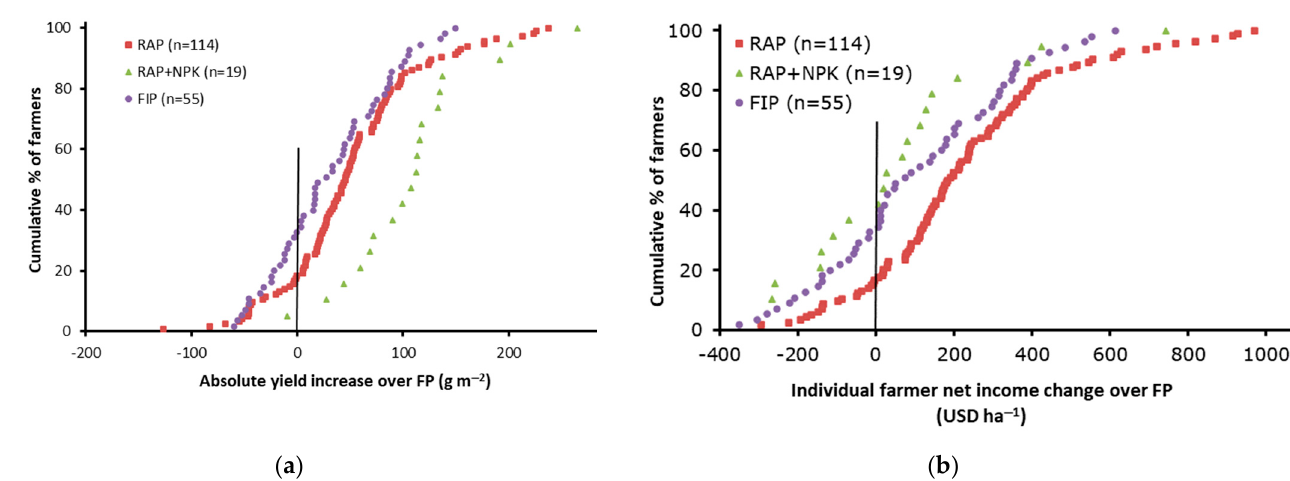
Figure 4. Cumulative frequency for absolute yield increment ( a ) and net income ( b ) over farmers’ practice due to the improved management packages tested: recommended agronomic practices without fertilization (RAP), recommended agronomic practices combined with NPK application (RAP+NPK) and farmers’ intensification practice (FIP) plotted as percentage of farmer population. Under FIP, the different intensification options which farmers considered feasible and, thus, evaluated included line transplanting, timely weeding, fertilizer use, as single options and in all possible combinations. Pair-wise comparison of yield for individual farmers under their current practice and any tested intensification practice, showed that timely weeding alone or in combination with other improved management practices, significantly ( p ≤ 0.01) increased grain yield in the fields of those farmers who evaluated these practices as their intensification options (Figure 5). Timely weeding as a single intensification option, and combined with line transplanting and fertilization, resulted in the highest yield gains of 80 and 73 g m − 2 , respectively, compared with yield under current practice for farmers who implemented these management practices as their intensification options. At an individual farmer’s field, for farmers who tested the different intensification practices, yield increment from different choices in the intensification (FIP) packages in- dicated that farmers who did late weeding under their current practice (FP) but timely weeded as an intensification step (FIP) had the highest yield increment, averaging 75 g m − 2 and ranging from 16 to 129 g m − 2 (Figure 6, yellow closed circles). Farmers who did timely weeding under both FP and FIP but increased fertilizer rate under FIP observed an average yield increment of 25 g m − 2 , with the yield increment ranging from − 60 to 117 g m − 2 (Figure 6, green closed triangles). Similarly, farmers who weeded late in both FP and FIP with late application of N(PK) or without NPK but in FIP did line transplanting only or line transplanting with higher fertilizer rate, increased fertilizer rate only or increased fertilizer rate and applied NPK blend instead of urea, had yield increments ranging from − 46 to 116 g m − 2 with an average yield increment of 18 g m − 2 (Figure 6, blue open diamonds). However, farmers who timely weeded in FP and FIP and, in the FIP tested line transplant- ing only or line transplanting with application of NPK blend instead of urea or only applied NPK blend instead of urea, observed, on average, negative yield increment ( − 13 g m − 2 ) (Figure 6, red closed